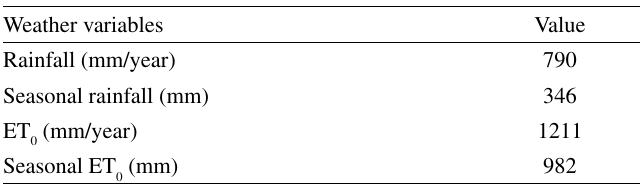
Table 1 - Annual and seasonal (March - September) weather variables